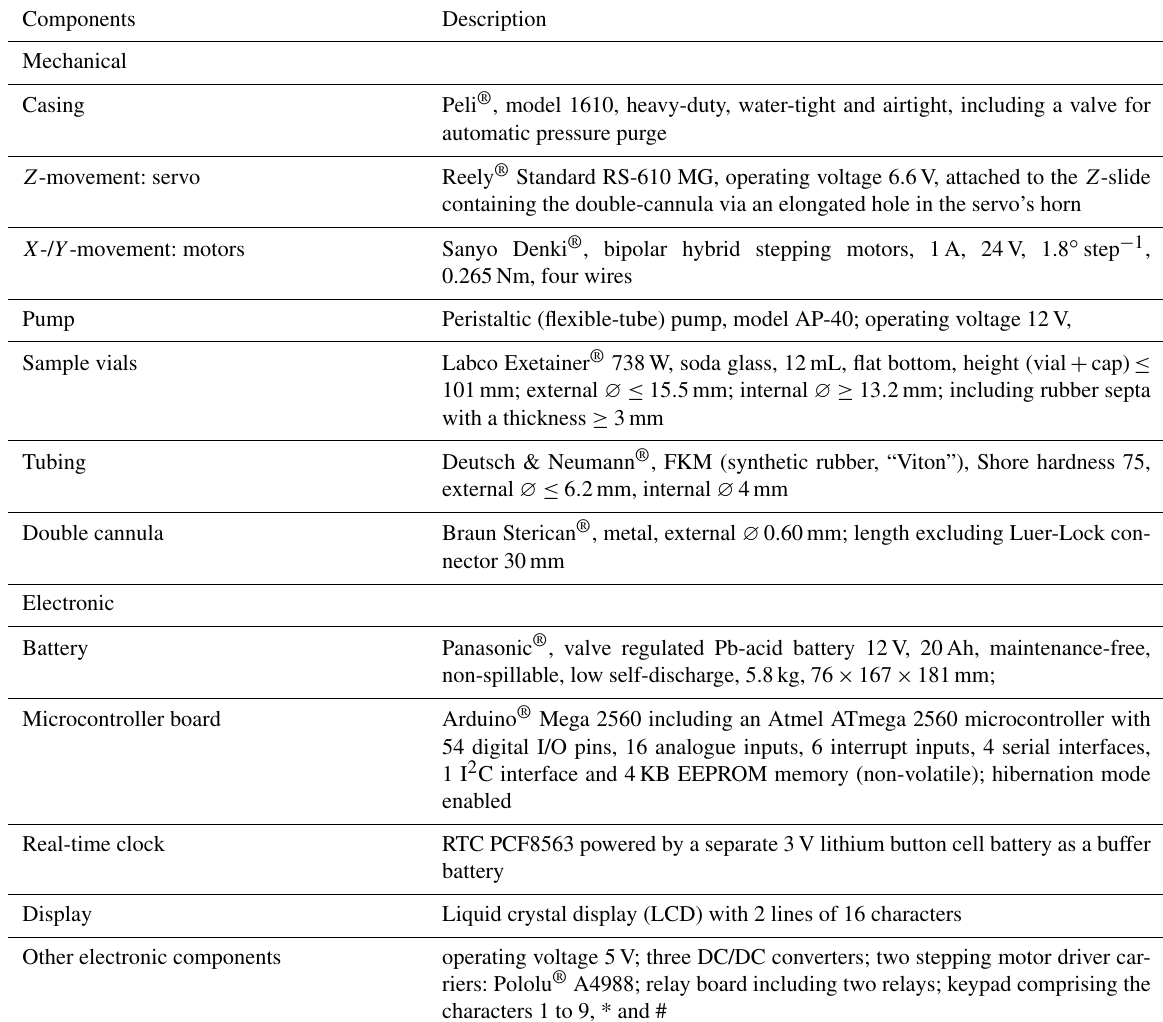
Table 1. Detailed description of the autosampler’s integral components.